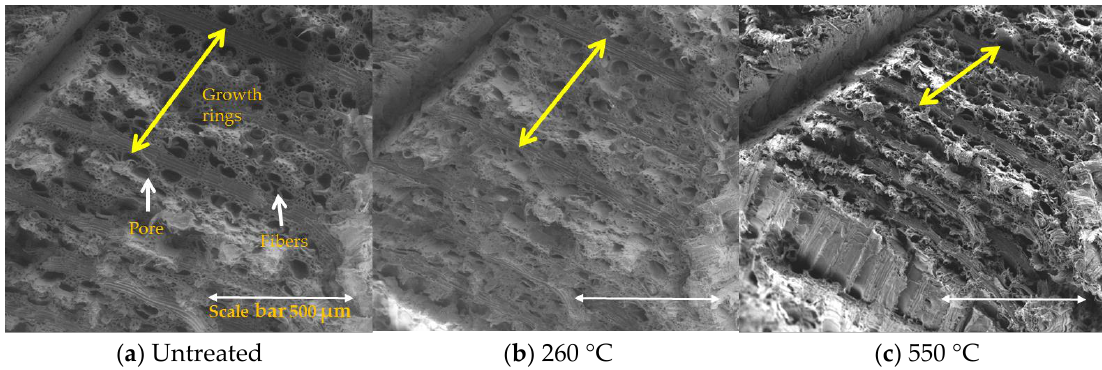
Figure 8. SEM images (horizontal field width = 1.28 mm; scale bar of 500 µm) of the cross section views of the untreated and the 300 and 550 °C treated cherry wood samples. White arrows point out fibers and pores. Yellow bars mark annual or growth rings and its shrinkage along the radial direction (using reference structures).